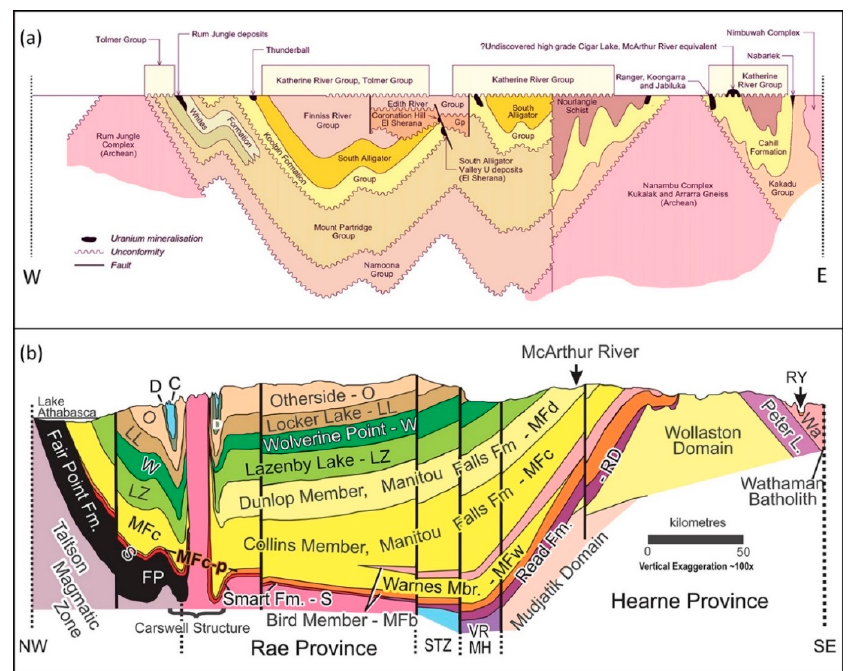
Figure 4. ( a ) Schematic diagram showing the position of major uranium deposits in the Pine Creek Inlier in relation to the Proterozoic unconformity. Igneous rocks other than basement units have been omitted. Approximate line of section is shown as W-E in Figure 2. Modified from Jaireth et al. [74], after McKay and Miezitis [75]. ( b ) Lithostratigraphic cross-section of the Athabasca Basin. Line of section is shown as NW-SE in Figure 3. Modified from Jefferson et al. [1], after Ramaekers [76] and Ramaekers et al. [77].